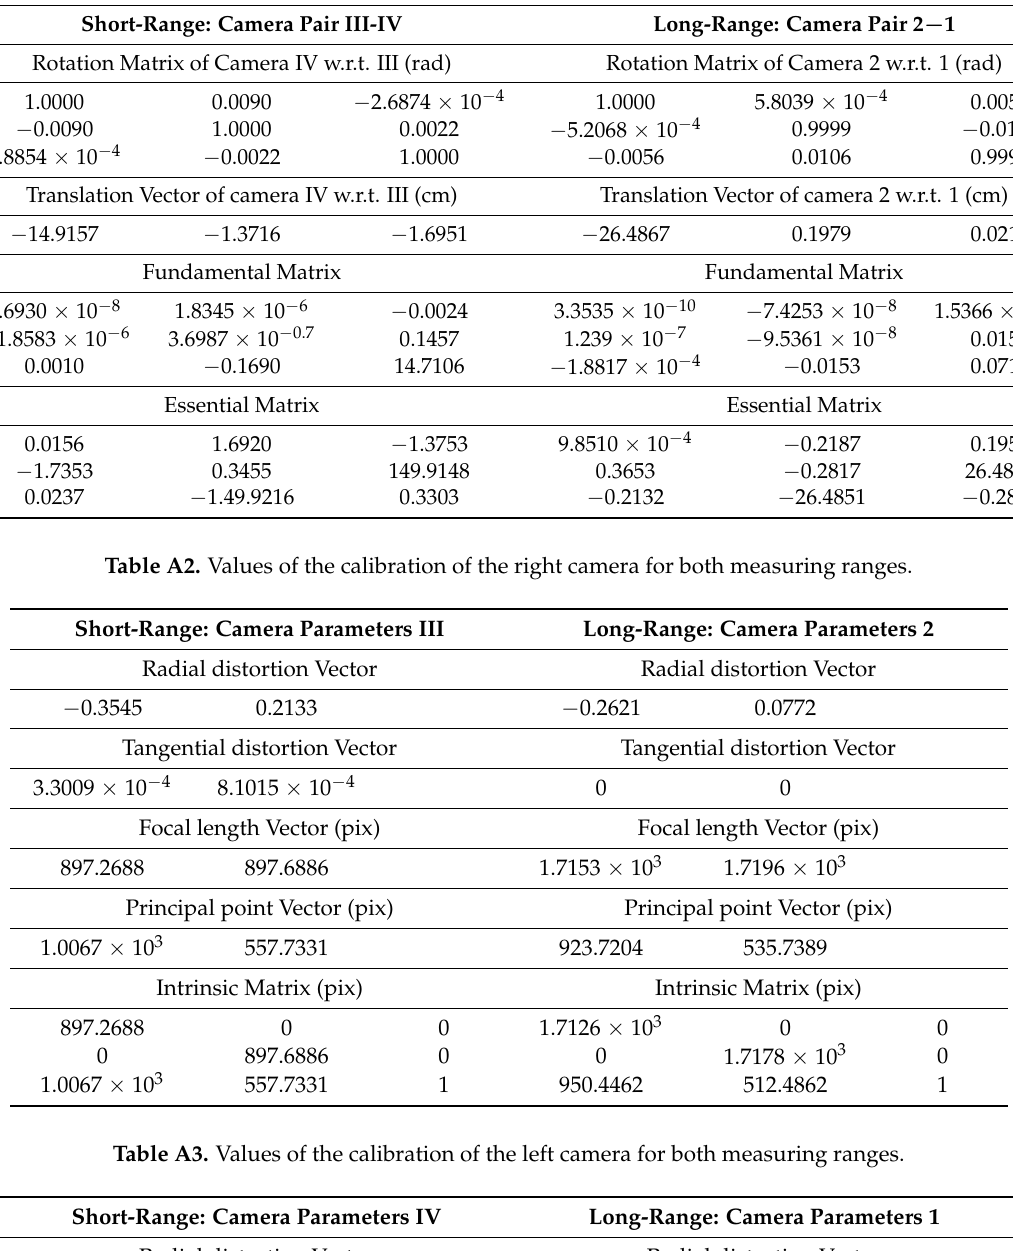
Table A1. Values of the calibration of the stereo rigs for both measuring ranges.